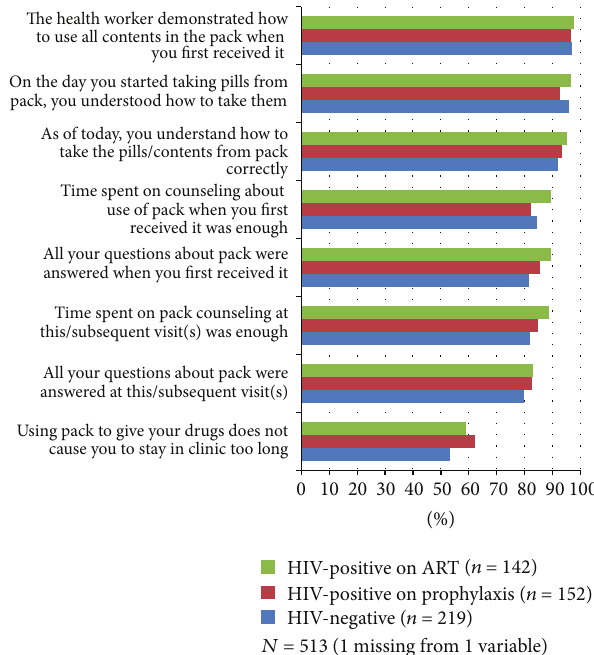
Figure 2: Percentage of structured interview participants that agree with the copackage acceptability statements by HIV status group. (Possible responses to statements included agree, disagree, and no opinion. “No opinion” responses ranged from 0.4 to 2.0% of the three groups combined for each statement, except the instruction sheet statement, in which 13.7%, 24.8%, and 22.0% of HIV-negative, HIV-positive on prophylaxis, and HIV-positive on ART women responded with “no opinion,” because they did not have or did not use the sheet.)